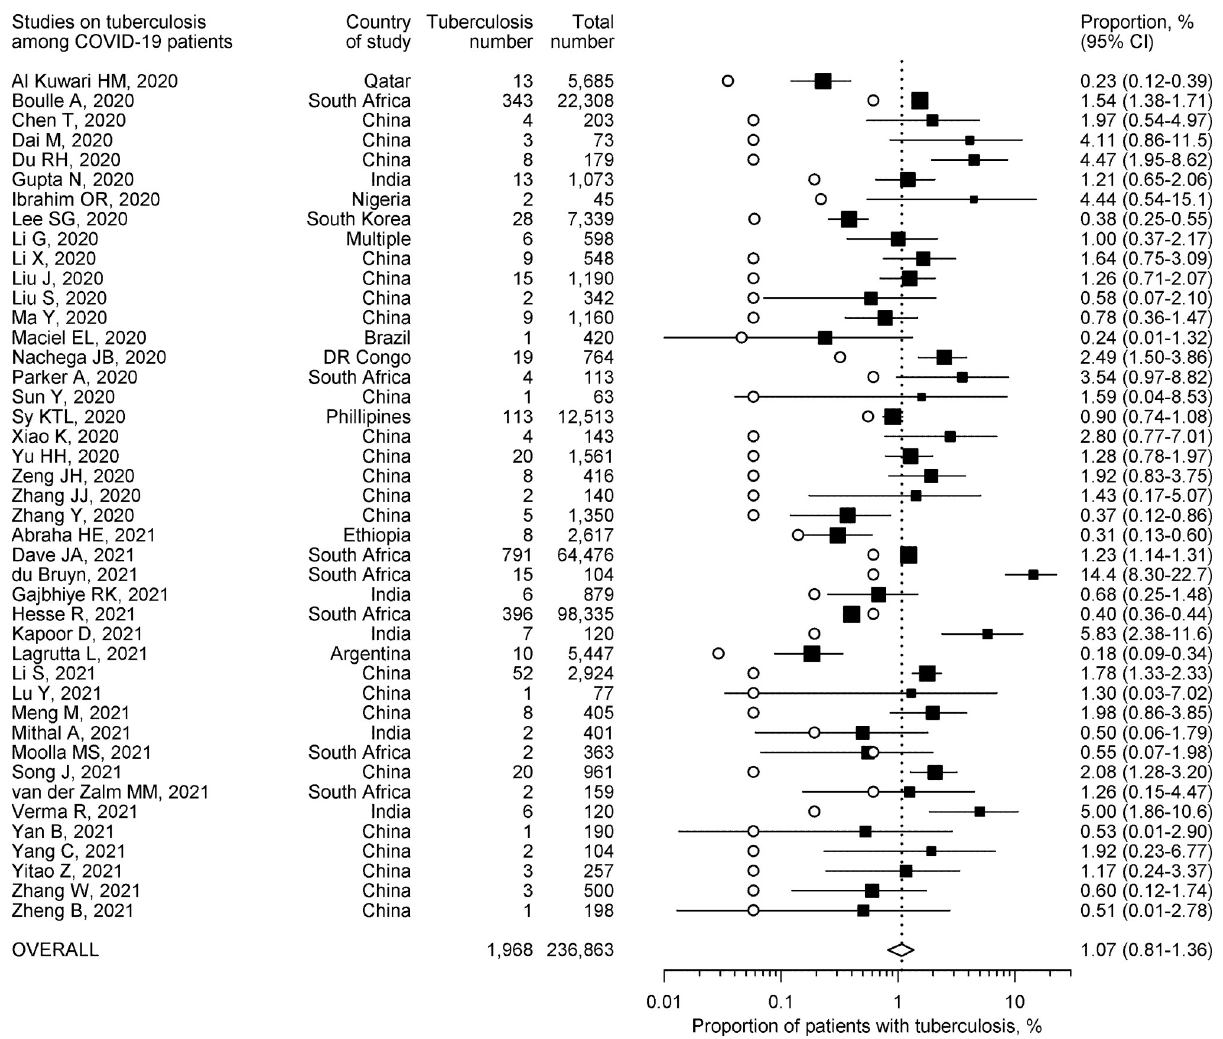
Fig 2. Proportion of COVID-19 patients also having tuberculosis and corresponding 95% confidence intervals (CI). Individual proportion estimates are depicted by solid squares, and the corresponding country estimate of annual tuberculosis incidence by hollow circles.